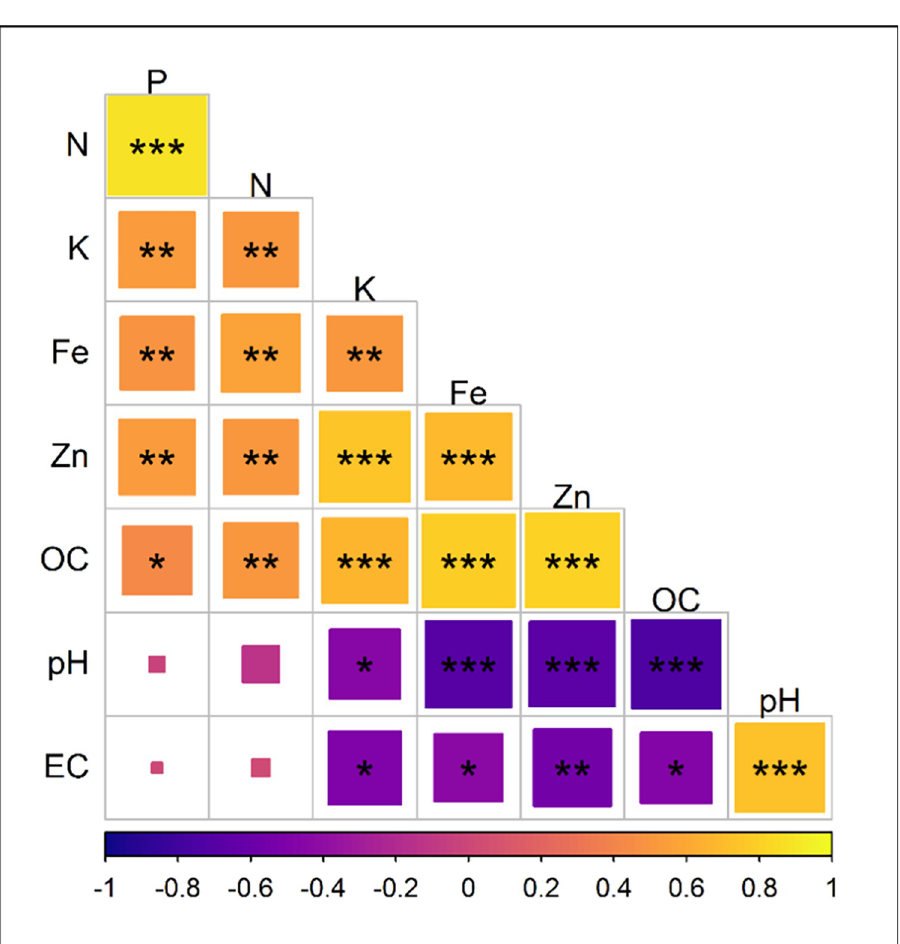
Fig 7. Correlation matrix of different soil properties based on R